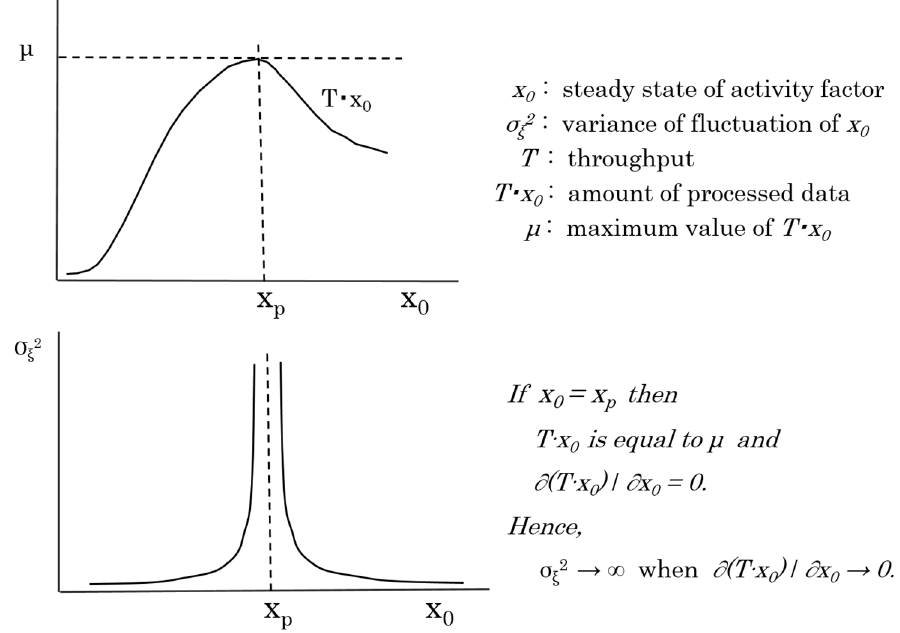
Figure 5. Image of the system’s behavior with respect to input transaction data.